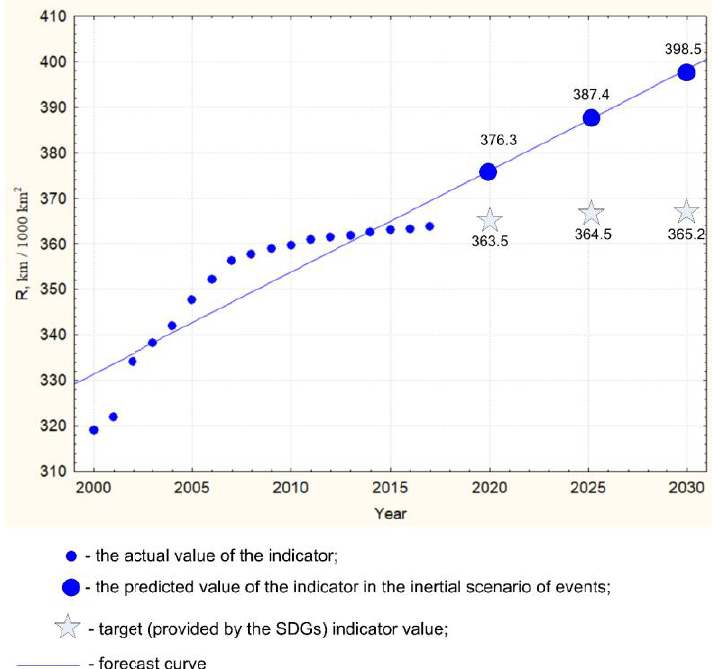
Source : National platform for reporting indicators of Sustainable Development Goals (SDGs)